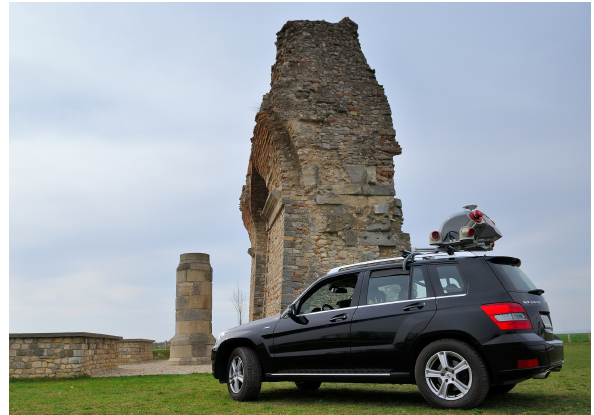
Figure 2: Study site: Heidentor, Carnuntum (Austria) together with the RIEGL VMX-450 system on top of a car.